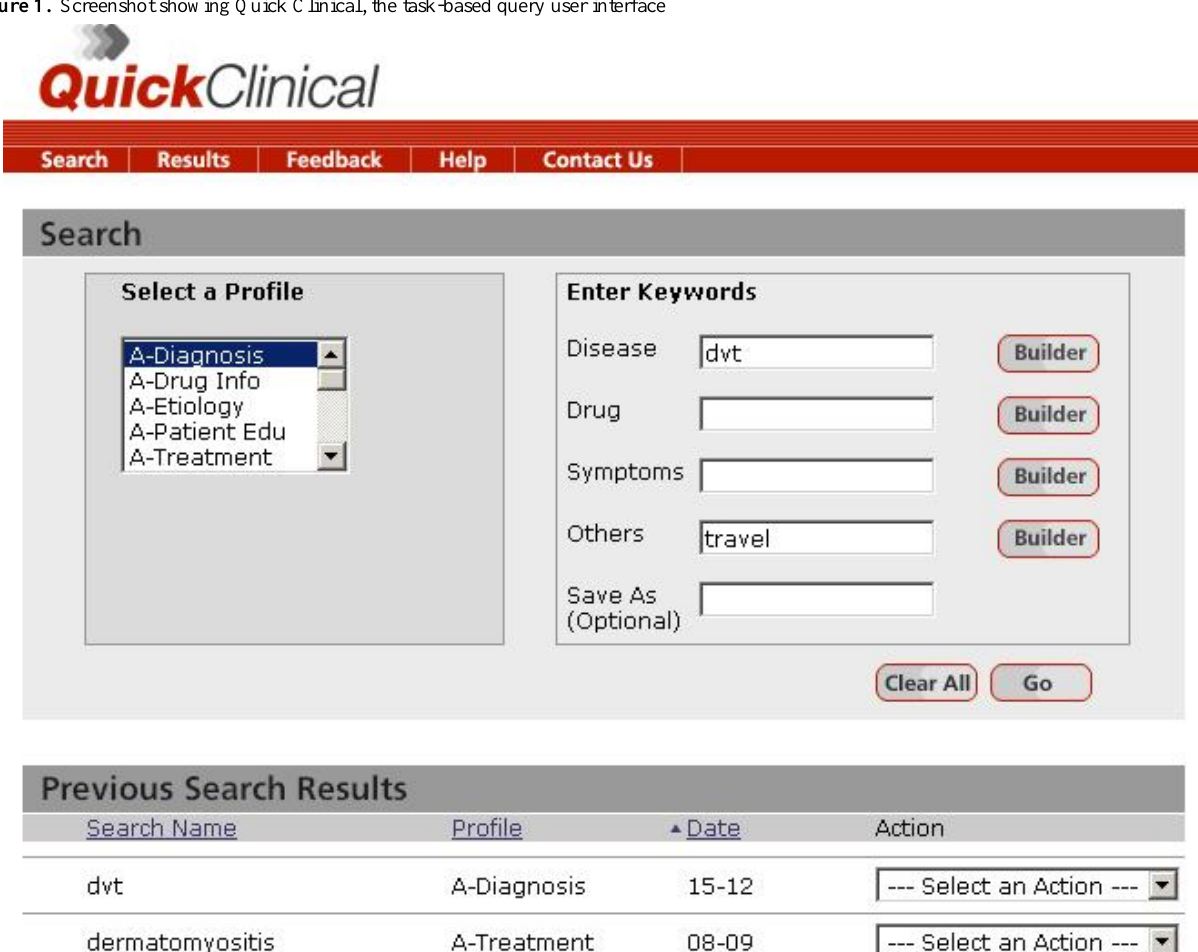
Figure 1. Screenshot showing Quick Clinical, the task-based query user interface